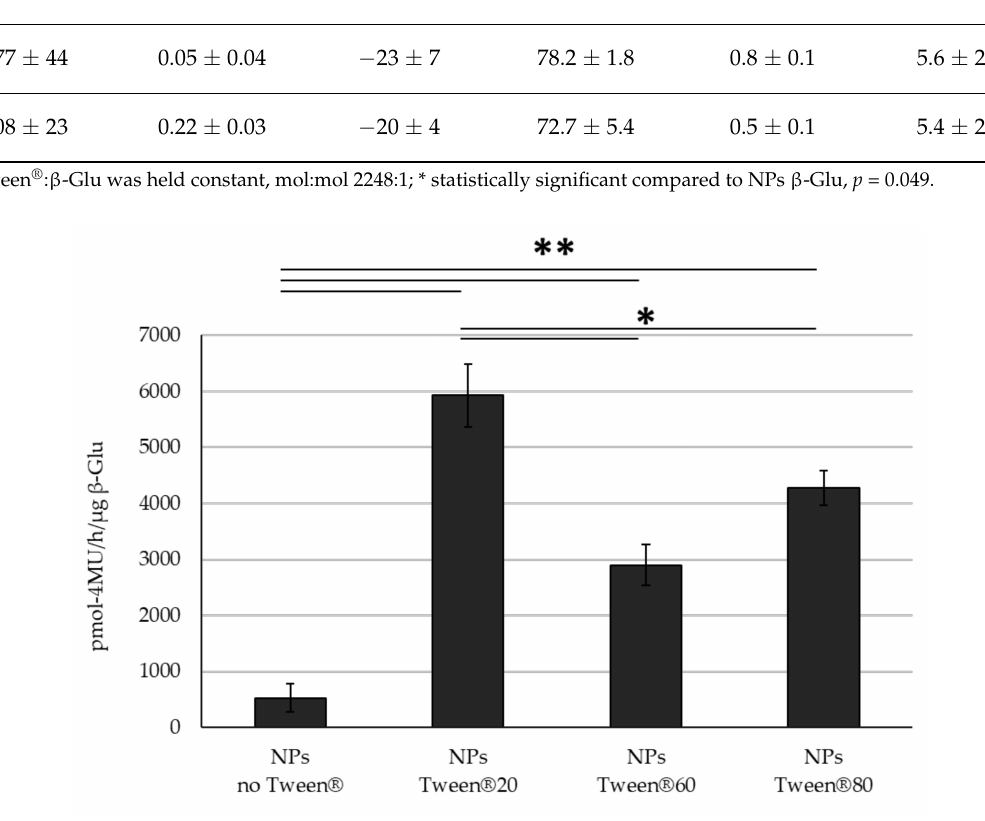
Figure 1. Activity Comparison. Activity of β -Glu mixed with Tween ® 20, 60, 80 and encapsulated into PLGA NPs. Statistical analysis was performed using the Student t test where * p < 0.05, ** p < 0.01 and N = 3 individual NP formulations for each